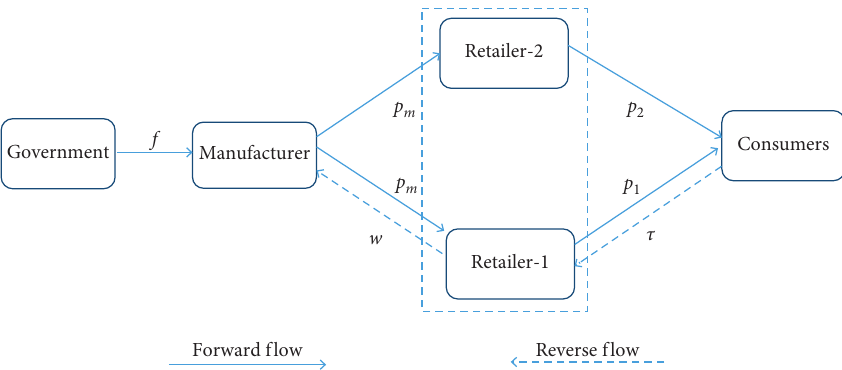
Figure 2: CLSC structure with two competing retailers with carbon emission